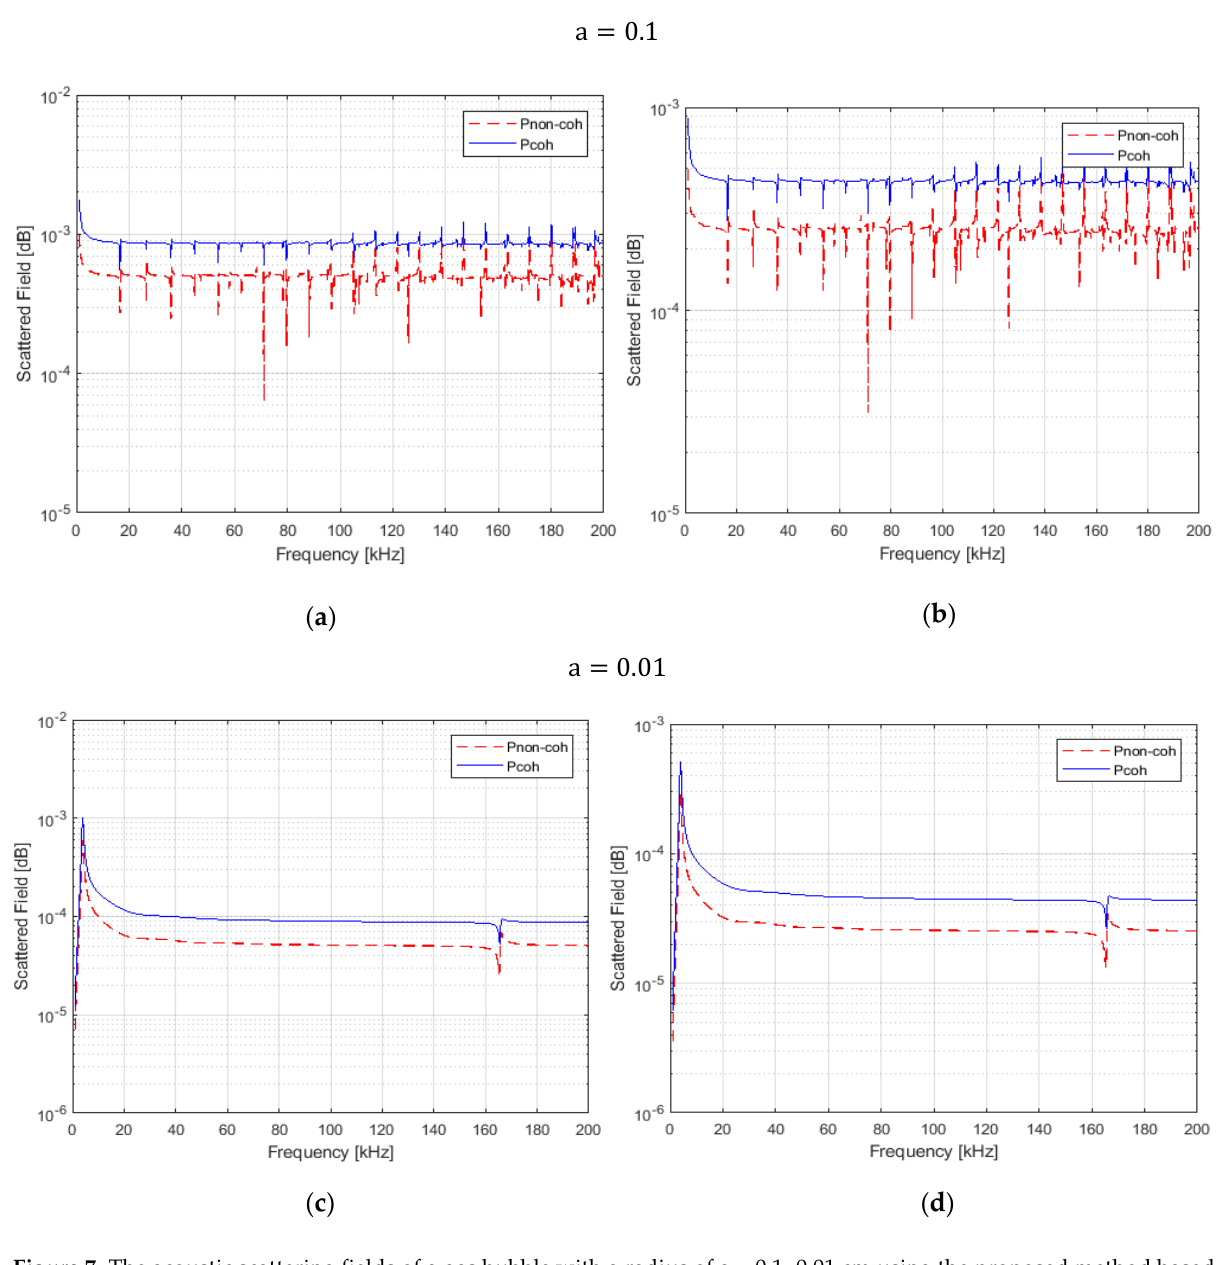
Figure 7. The acoustic scattering fields of a gas bubble with a radius of a = 0.1. 0.01 cm using the proposed method based on SAS system P coh in range migration and using the real aperture P non − coh in broadside range at different depths as a function of frequency: ( a,c ) depth of 100 m; ( b,d ) depth of 200 m.